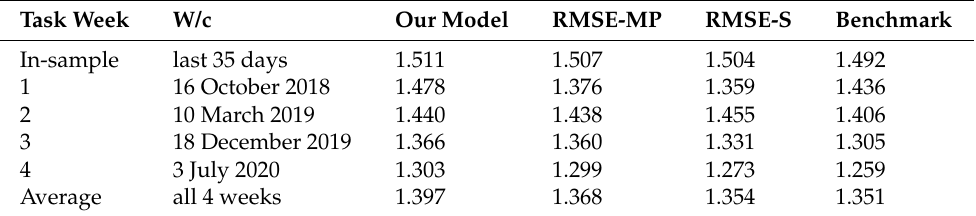
Table 3. The average daily peak reduction in MW achieved by the four forecast models. The greater the peak reduction the better. Presented are the results for each of the 4 task weeks averaged over the 7 days in those task weeks. In addition, the average result across those 4 task weeks is provided. Also presented are the “In-sample” calibration model peak reduction averaged over the 35 days closest to the task week and while some of those days are quite distant from the task week and are in-sample they do provide an average result across more days and so are more